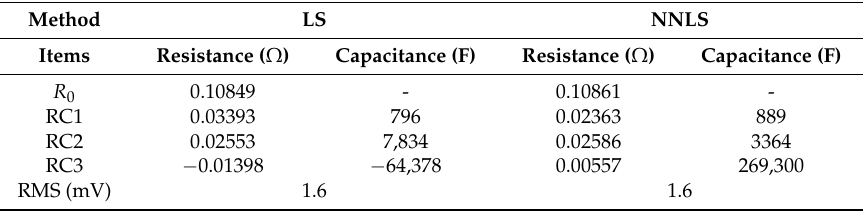
Figure 3. Battery voltage and voltage errors of the three-RC-pair circuit model from SOC = 60% to 50%: ( a ) a current pulse series: the unit for the x -axis is hours; ( b ) current; ( c ) voltage; ( d ) voltage error.